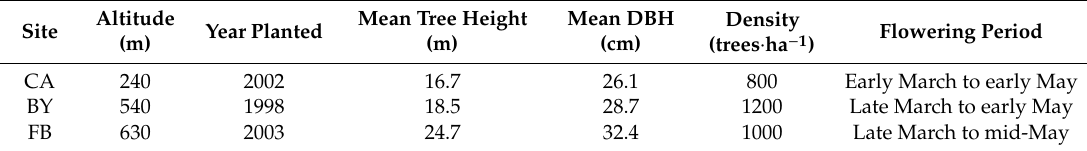
Table 1. Basic characteristics of M. conifera plantations in Guangxi.